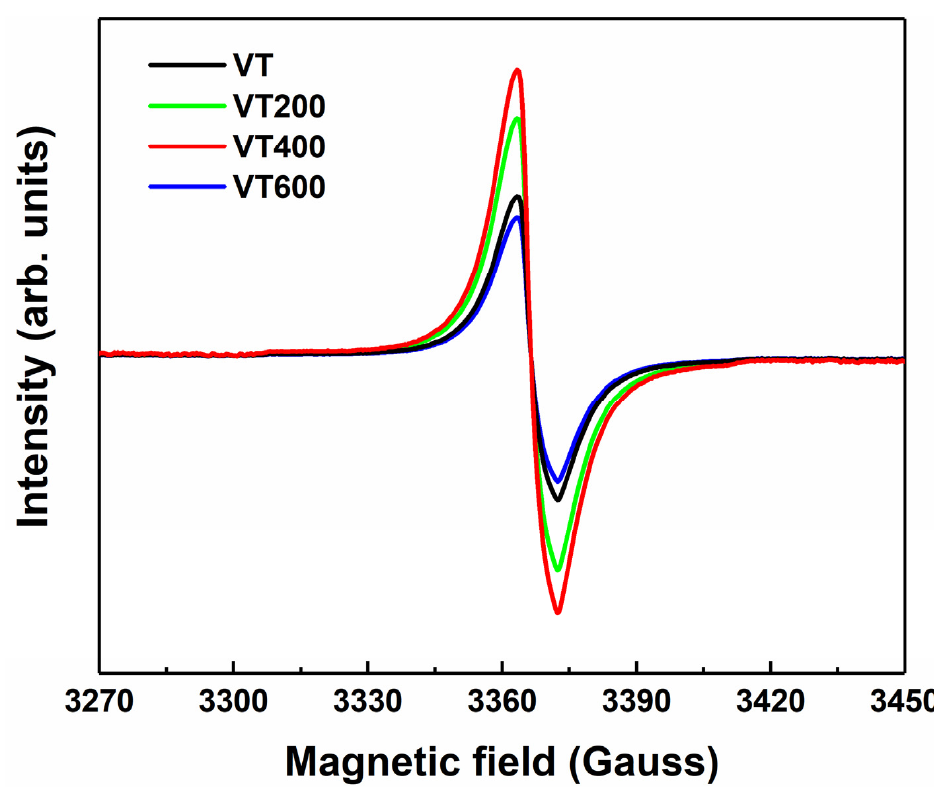
Figure 4. ESR spectra of VT, VT200, VT400, and VT600.